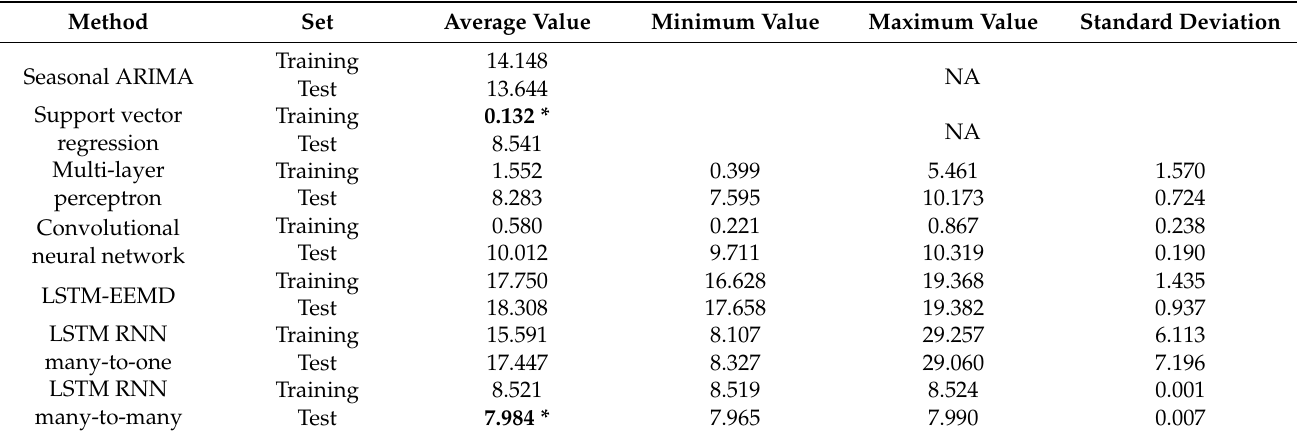
Table 5. Mean absolute error for artificial dataset.